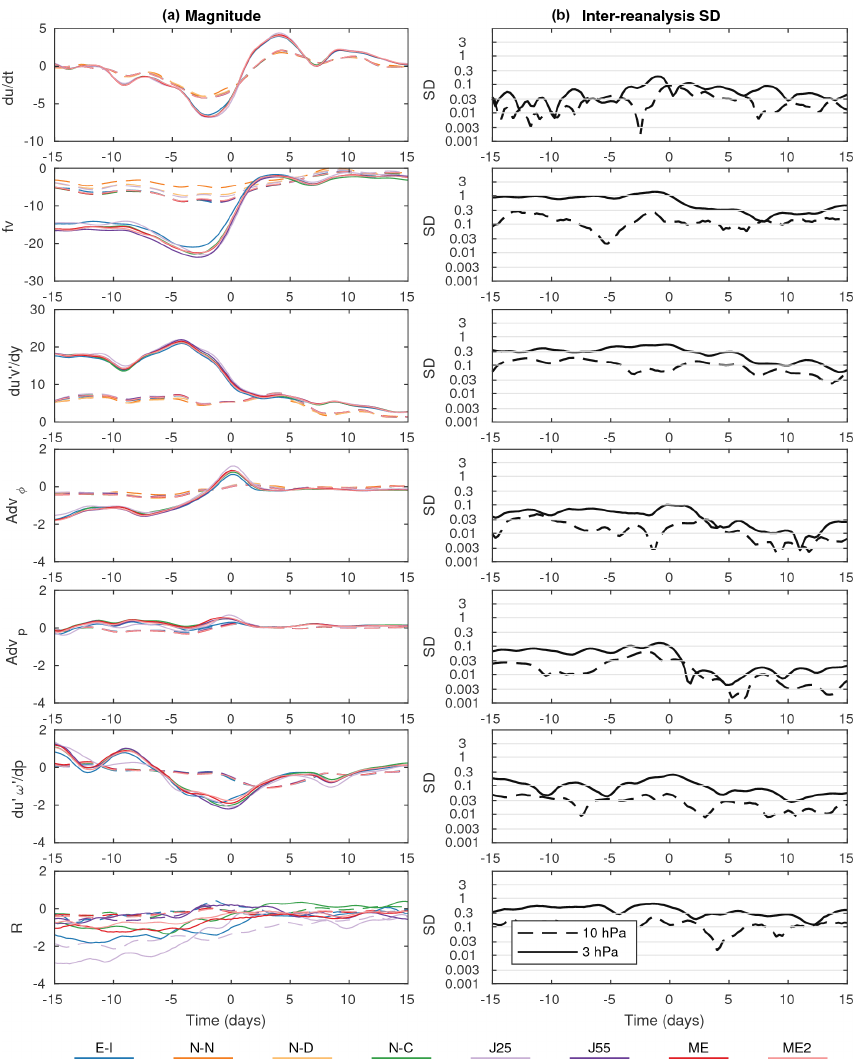
Figure 5. (a) Evolution of forcing terms of the zonal-mean momentum equation at 10hPa (dashed lines) and 3hPa (solid lines) in the course of SSW events. All variables are averaged from 45 to 85 ◦ N. Note that the range of y axis in each panel is different. (b) The inter-reanalysis spread (standard deviation) of the corresponding terms are shown for the LRE members. The standard deviation is shown on a logarithmic scale: the spacing between tick marks represents a decrease or increase of the standard deviation by a factor of about 3. All quantities are expressed in ms − 1 day − 1